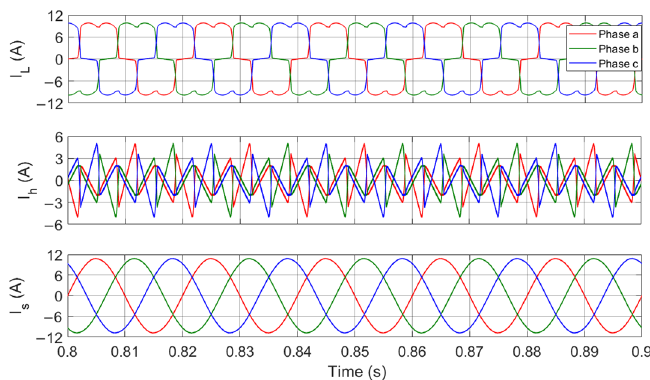
Figure 7. waveforms of I L , I h , and I s using the proposed MPM extraction.